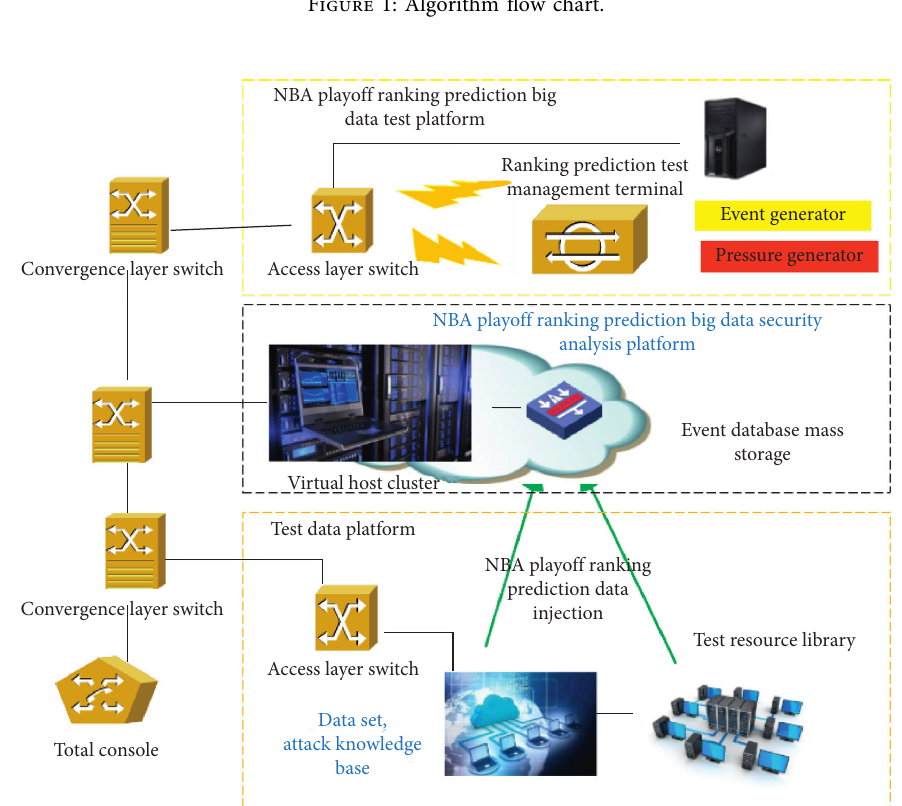
Figure 1: Algorithm flow chart.